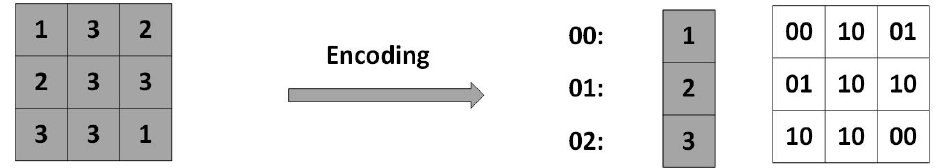
Figure 3. Example of encoding.